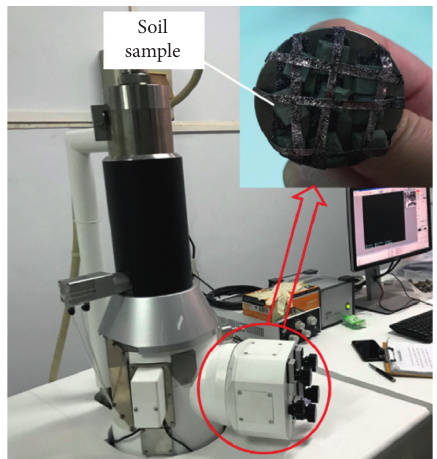
Figure 17: The scanning electron microscope and soil